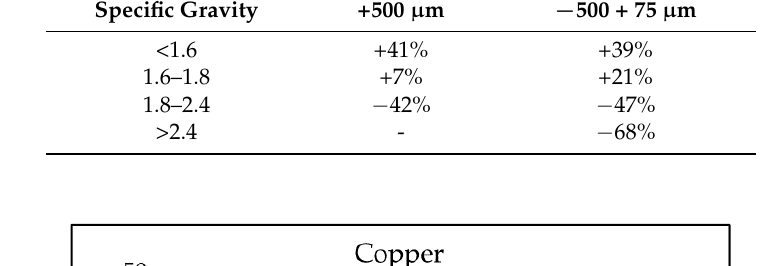
Table 2. Percentage change in the calorific value of various destiny fractions compared to the